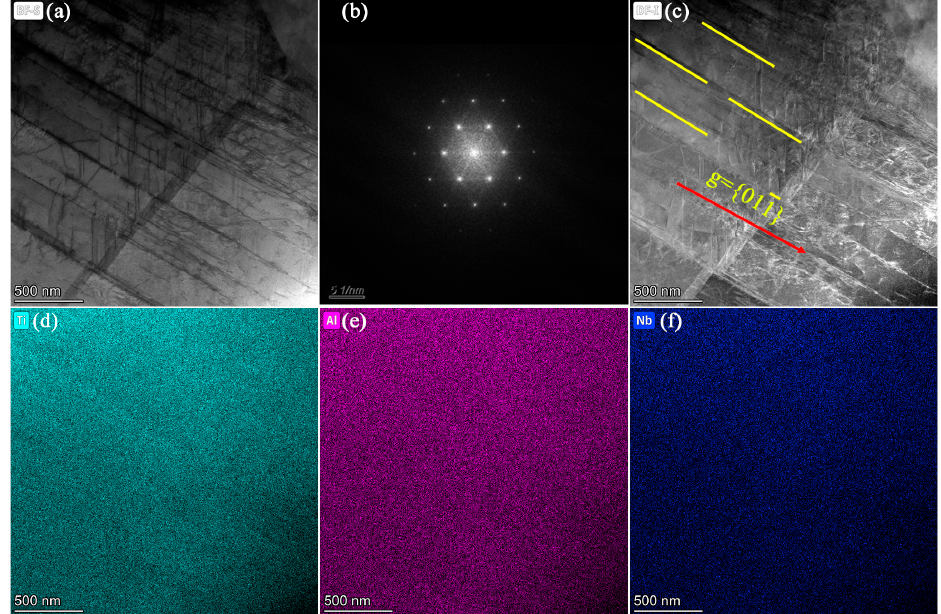
Figure 13. ( a ) TEM image of S1 (scanning speed: 600 mm/s). ( b ) SAED pattern corresponding to ( a ). ( c ) Bright-field image under double-beam condition. ( d – f ) HAADF mapping images of Ti, Al, and Nb.